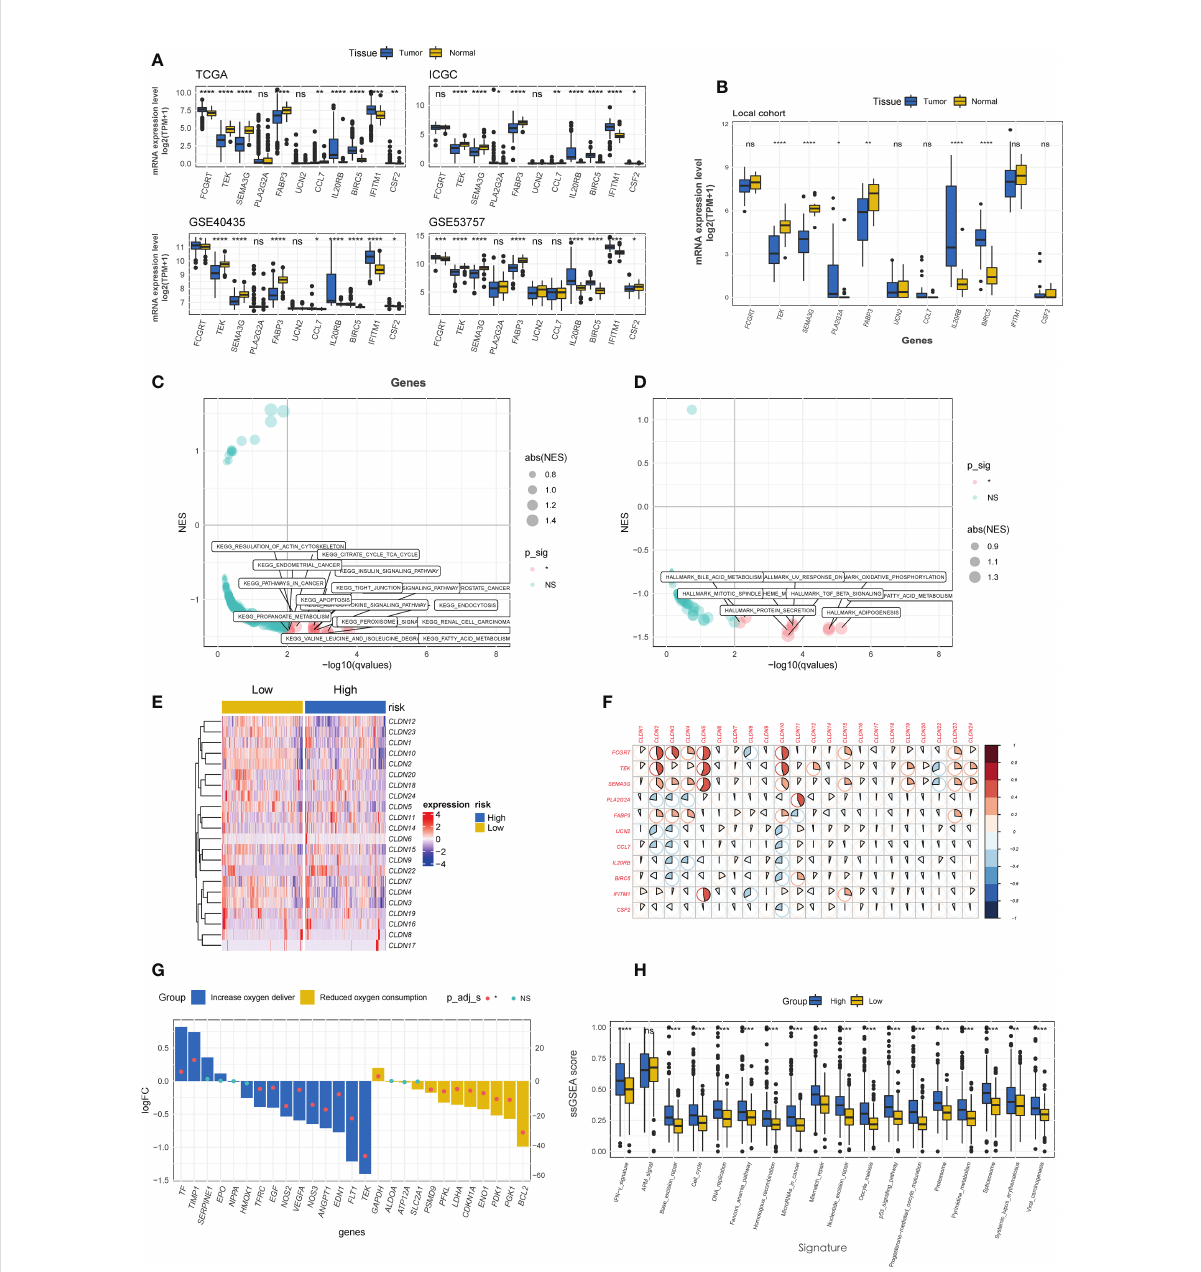
FIGURE 7 Enrichment analysis of CTR score. (A) Comparison of the expression difference of eleven claudin-TME related (CTR) score-related genes between tumor and normal tissues in TCGA, GSE40435, GSE53757 and International Cancer Genome Consortium (ICGC) datasets. (B) Difference in the expression level of 11 CTR score-related genes between tumor and normal tissues in local ccRCC patients. Kyoto Encyclopedia of Genes and Genomes (KEGG) (C) and Hallmark (D) pathways analysis revealed that the pathways were signi fi cantly enriched in the differentially expressed genes (DEGs) between high and low CTR groups in the TCGA-KIRC cohort. Only the signi fi cantly enriched pathways are shown in the fi gure. (E) Heatmap of the expression of claudin genes in high and low CTR groups in the Cancer Genome Atlas-kidney clear cell carcinoma (TCGA-KIRC) cohort. (F) Correlation between CTR score related genes and claudin family genes. (G) Expression changes (high vs. low CTR groups) of target genes involved in the hypoxia- inducible factor-1 (HIF-1) KEGG pathway. (H) Difference in the enrichment scores of immunotherapy-predicted pathways between high and low CTR groups. *p< 0.05, **p< 0.01, ***p< 0.001, ****p< 0.0001, ns, not signi fi cant; TPM, transcript per million; ssGSEA, single-sample gene set enrichment analysis; NES, normalized enrichment